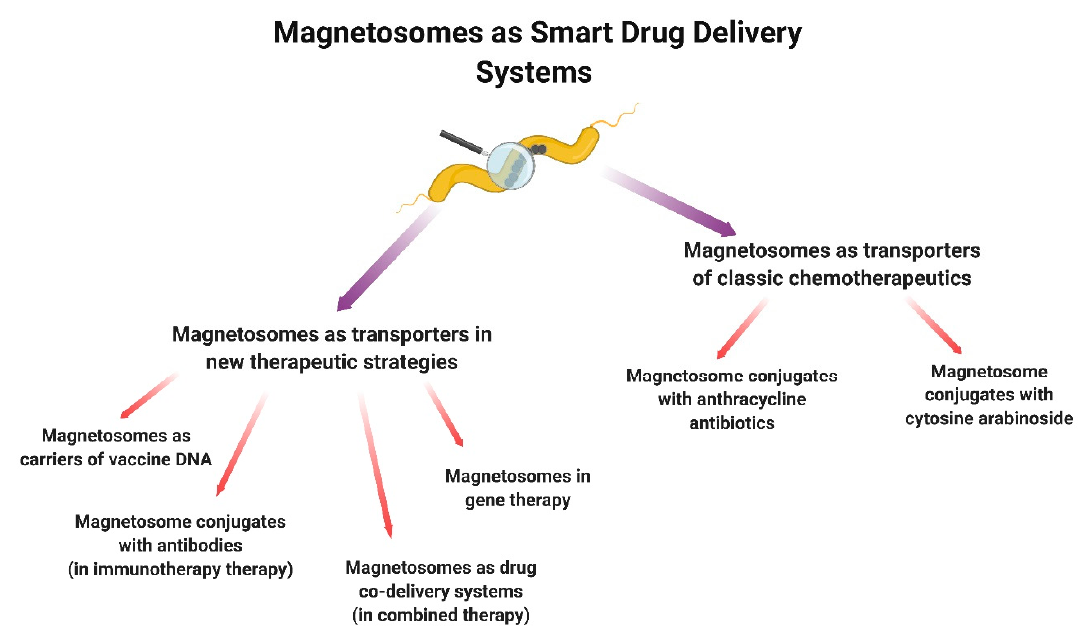
Figure 4. Application of magnetosomes for drug delivery in cancer